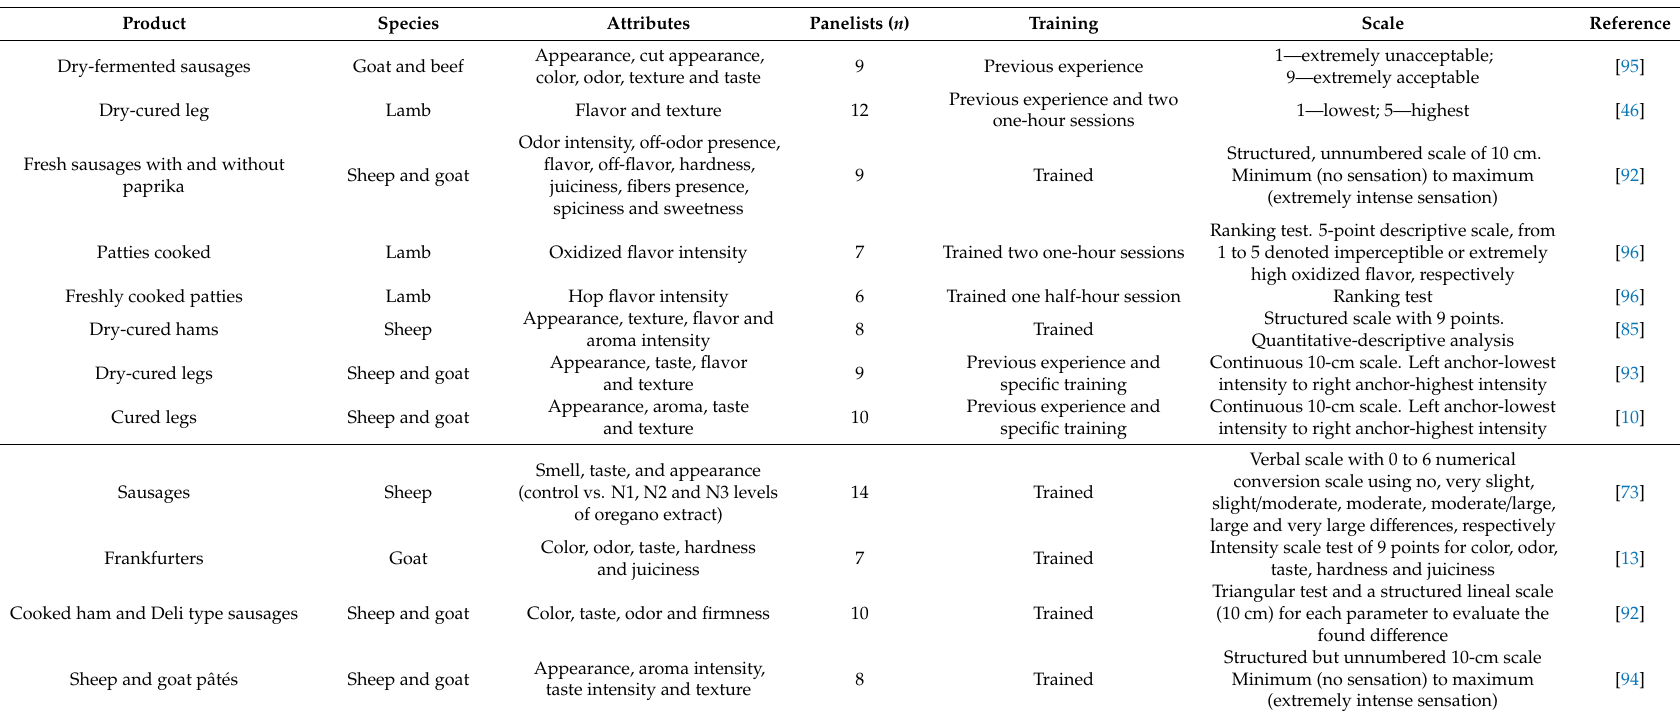
Table 2. Principal studies on the sensory evaluations of new products from sheep and goat meats with trained or experienced